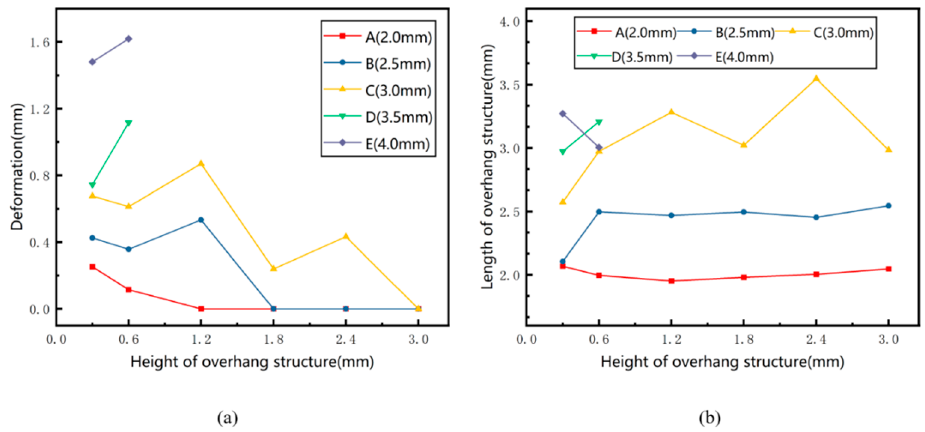
Figure 5. Experiment results: ( a ) deformation and ( b ) formed length of overhang structure.